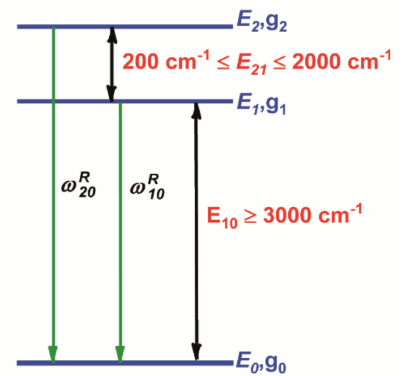
Figure 1. Simple scheme for thermal coupled energy levels theory. E 21 is the energy gap between the two excited levels E 2 and E 1 , g is the degeneracy of the i-th level and ω R i rate between the i-th and j-th